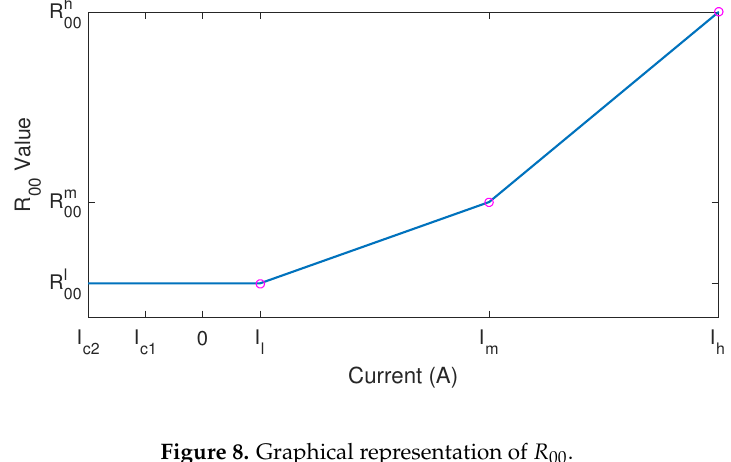
Figure 8. Graphical representation of R 00 .